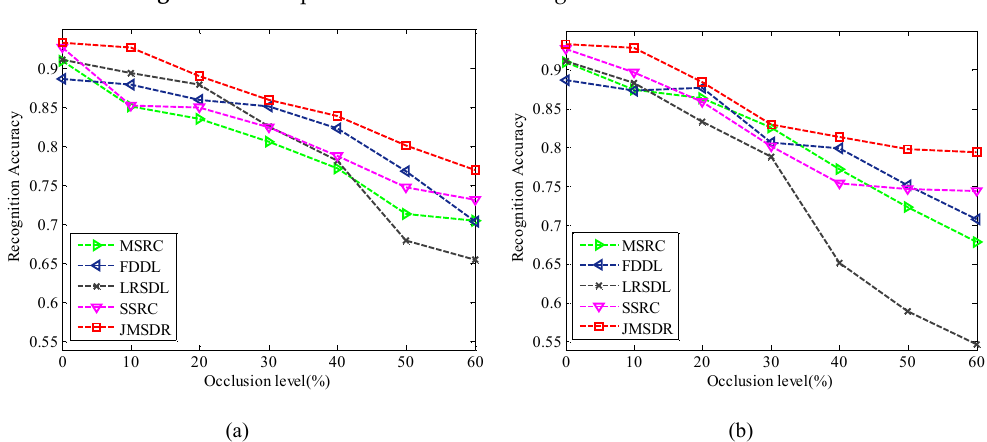
Figure 12. The recognition results of different methods at different level of occlusion from different directions. ( a ) Direction 1 for training samples and direction 3 for testing samples. ( b ) Direction 1 for training samples and direction 5 for testing